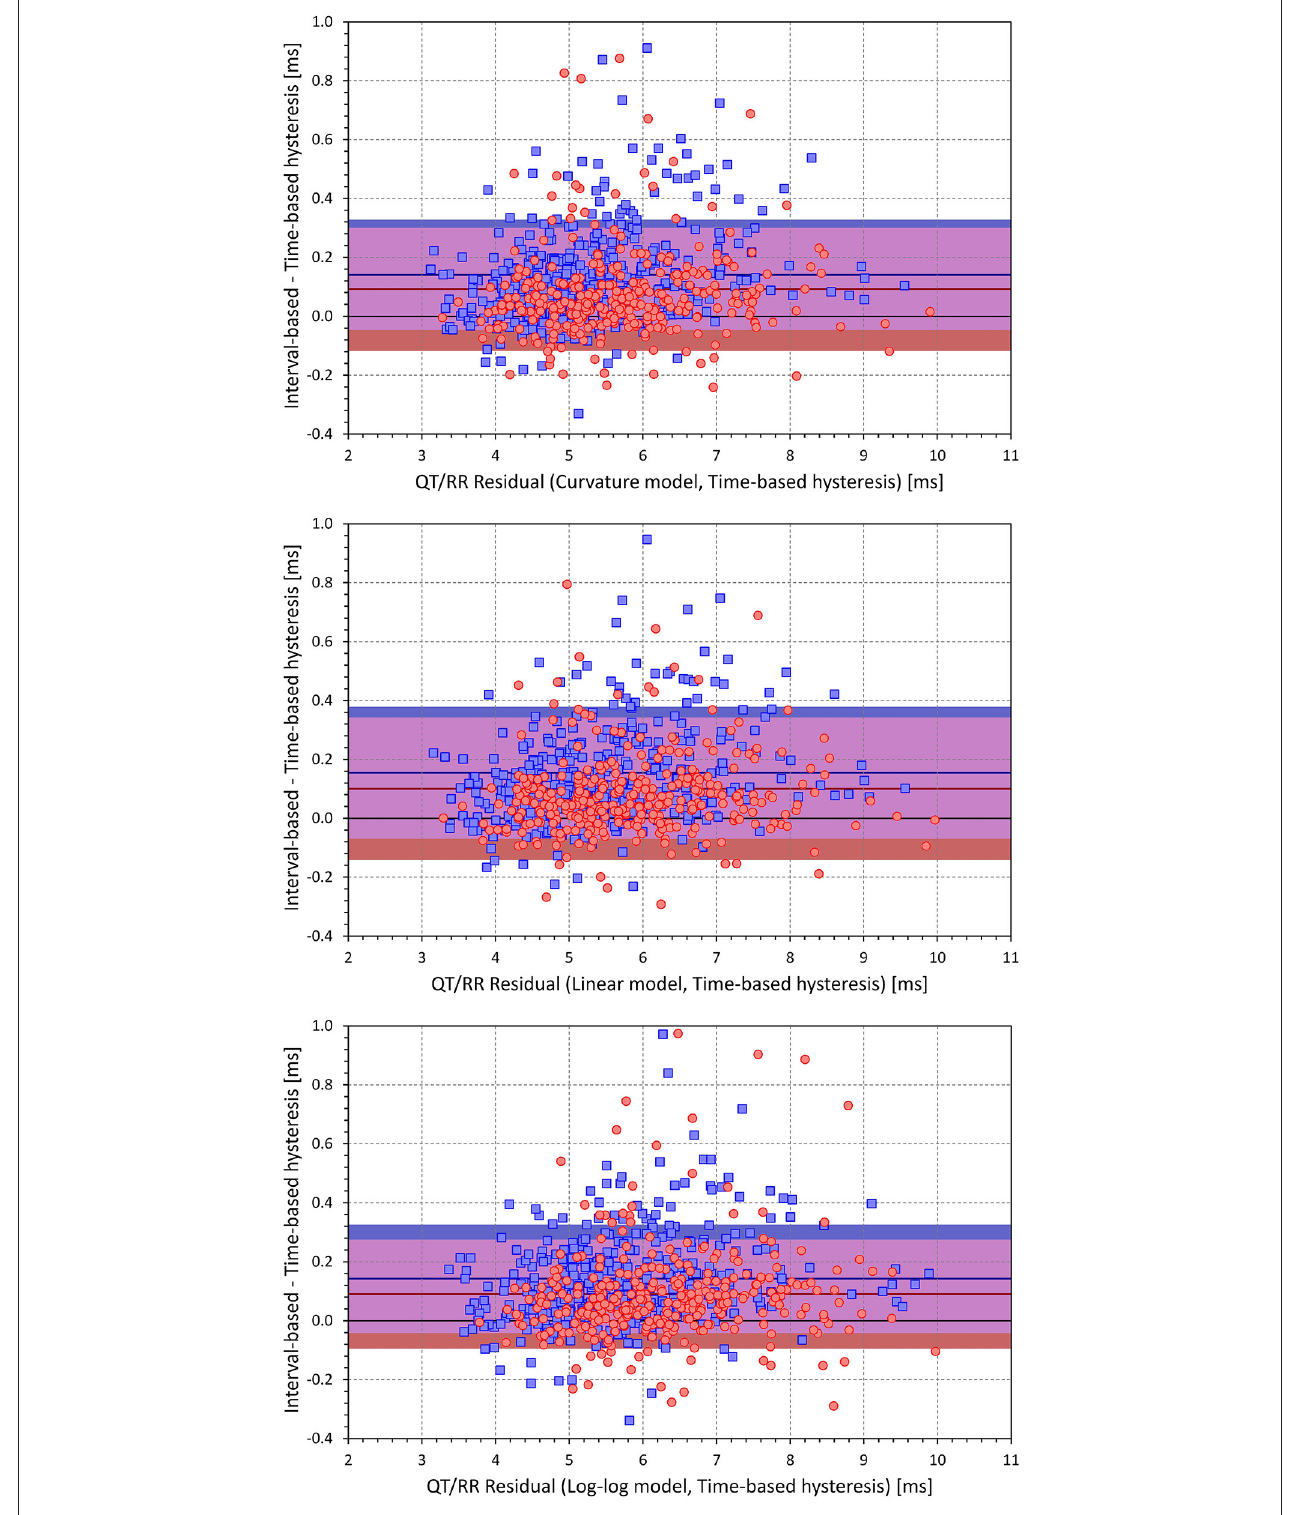
FIGURE 9 | Scatter diagrams of the intra-individual differences among regression residuals comparing the interval-based and time-different QT/RR hysteresis models. The differences between the residuals and the residuals of the time-based QT/RR hysteresis model are shown for the QT/RR H curvature model in the top panel,